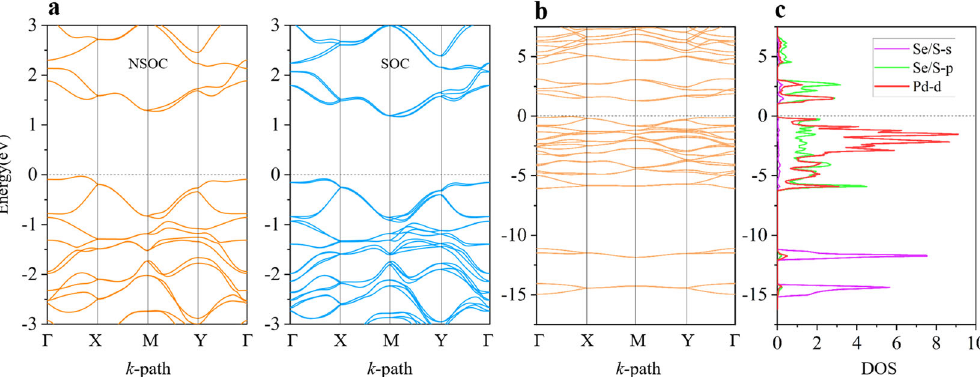
Fig. 4 Electronic properties of penta-PdSSe. a Band structures around the Fermi level with and without SOC. b Band structure with all valence bands, and c the corresponding partial